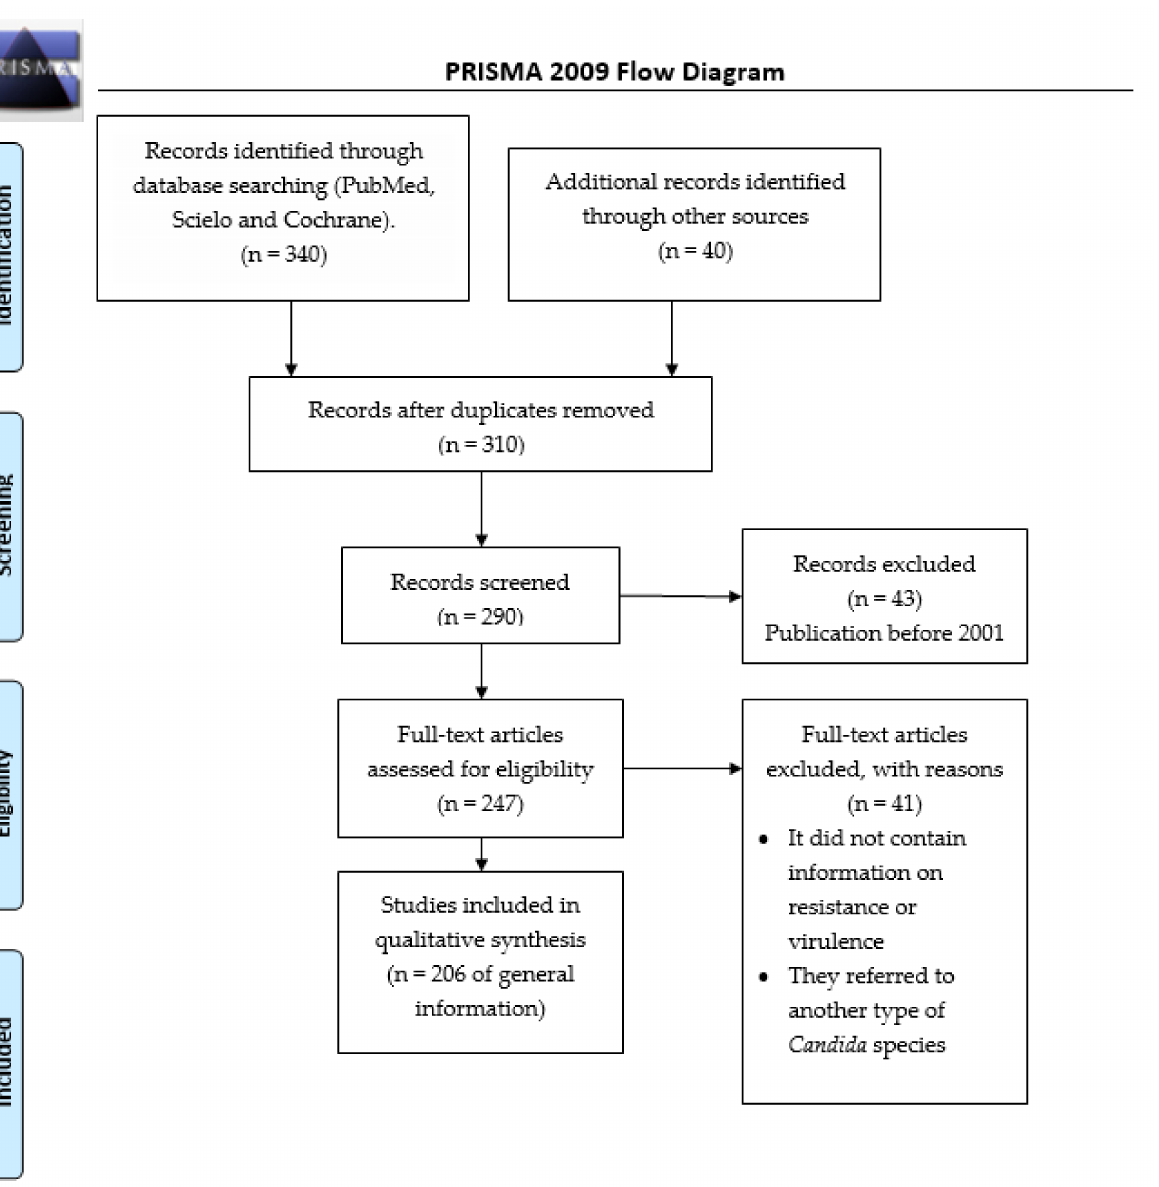
Figure 1. Flowchart of the different phases of the systematic